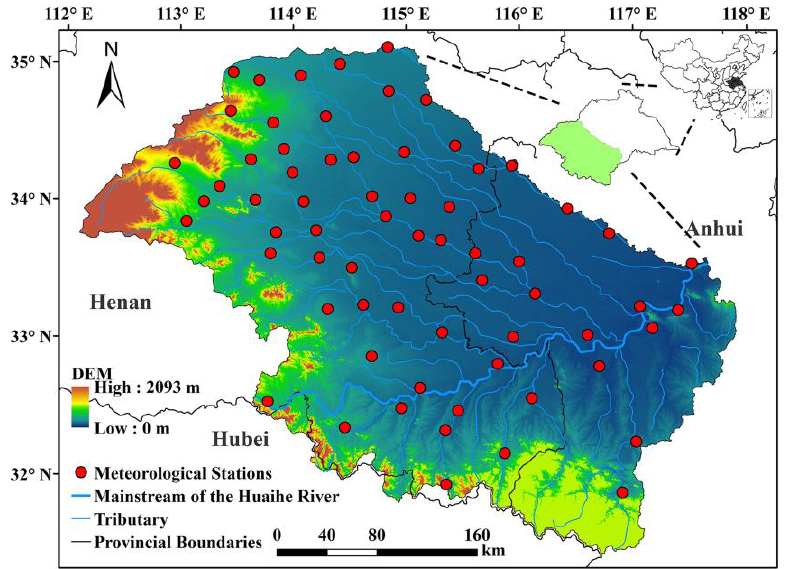
Figure 1. Digital elevation map (DEM), meteorological stations, and river in study area.